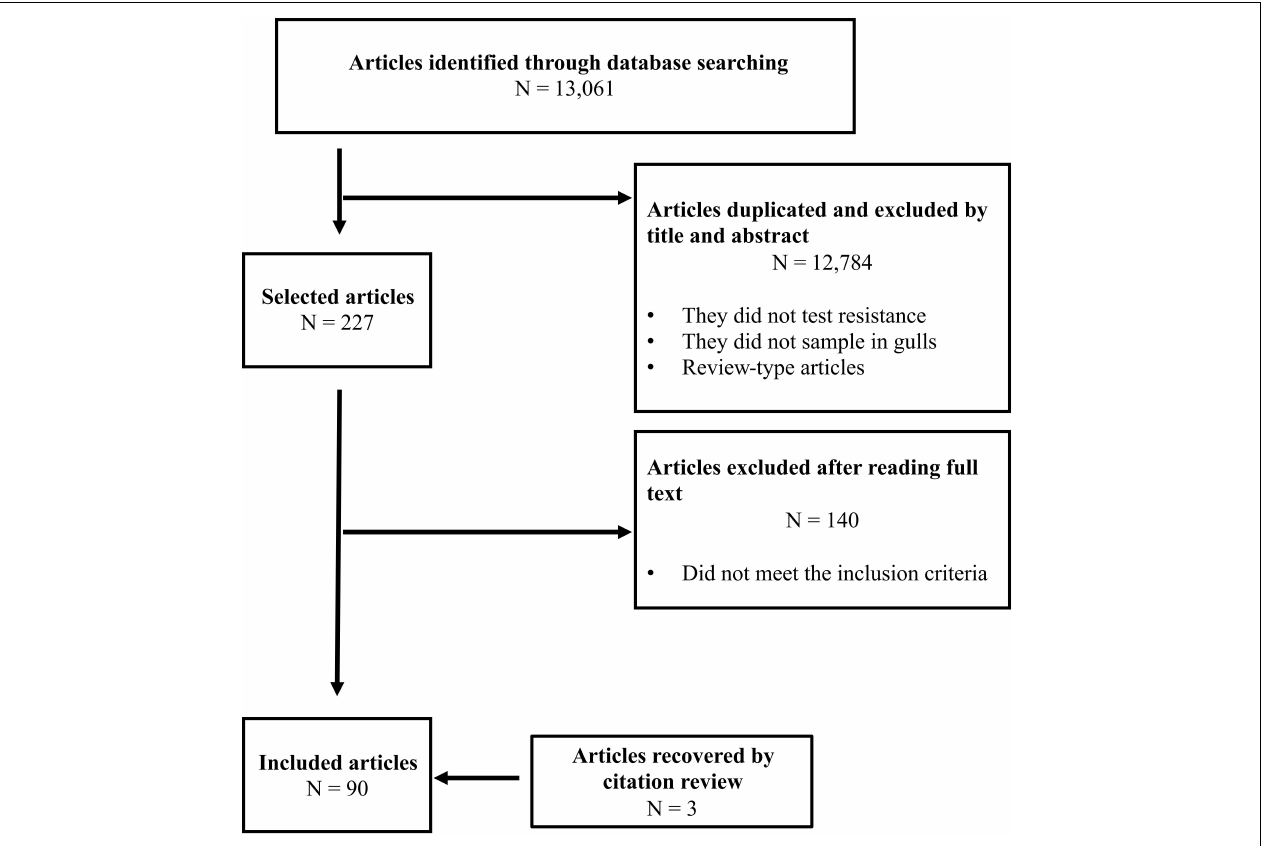
FIGURE 1 | Article search flow